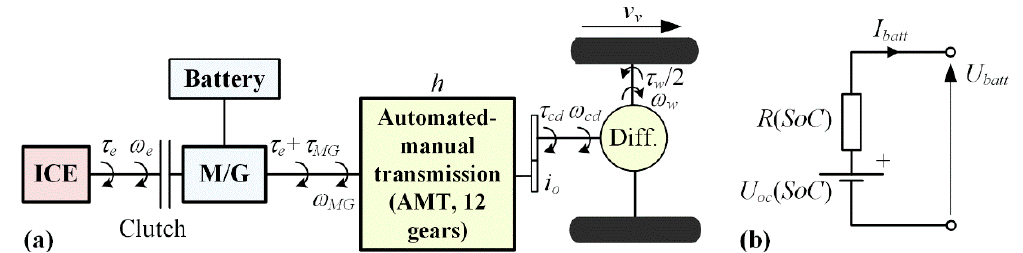
Figure 9. Functional scheme of considered parallel HEV / PHEV powertrain ( a ) and battery equivalent circuit model ( b